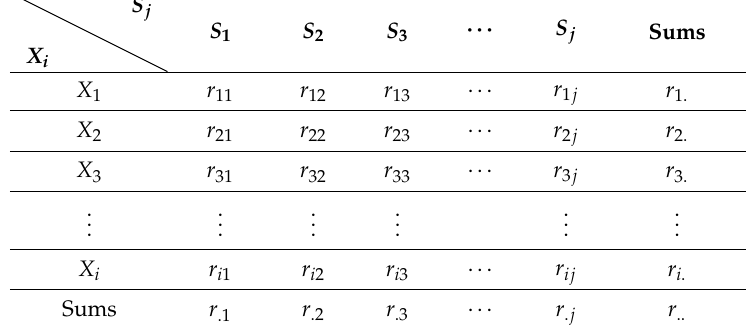
Table 3. Notation for comparing the target cluster X i and the clustering result S j . S j S 1 S X i